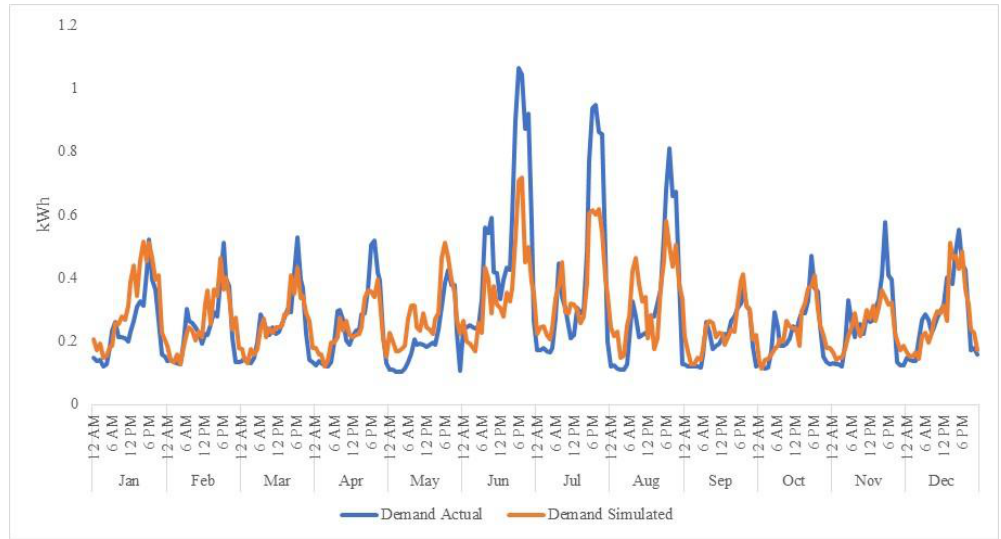
Figure 6. Simulated household demand and historical data daily half hour averages by month.